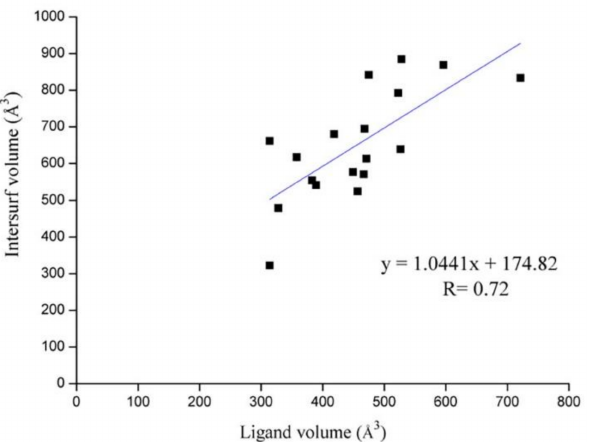
Figure 15. Correlation between ligand volumes and intersurf volumes in BTK–inhibitor complex structures. The ligand and intersurf volumes were calculated using UCSF Chimera [102] and the correlation coefficient is